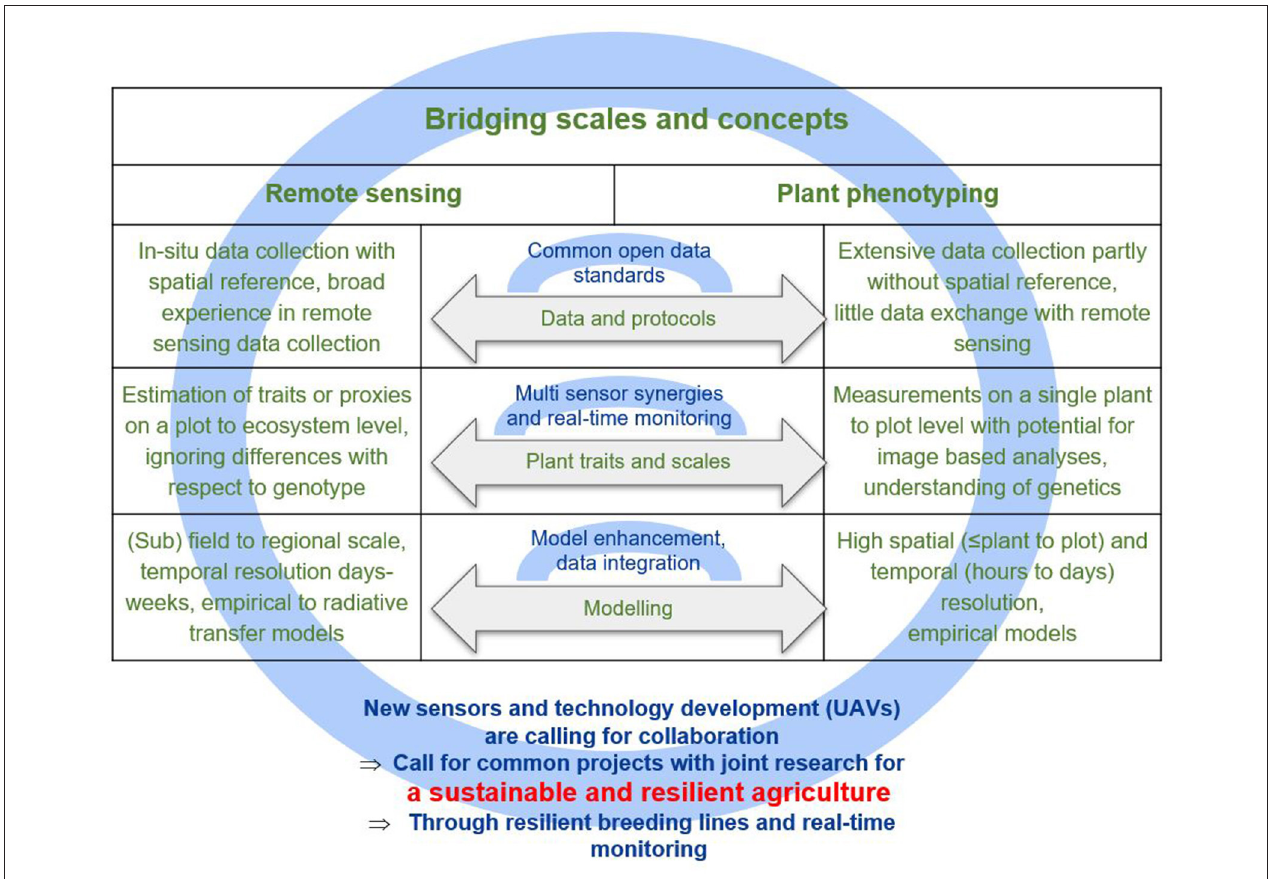
FIGURE 1 | A closer collaboration of remote sensing and plant phenotyping has the potential to foster research for a sustainable and resilient agriculture. Common topics between the two communities (gray arrows) have been identified for collaboration and cutting-edge research. In the left and right columns, differences between remote sensing and plant phenotyping are listed regarding the three topics. In blue, the potential for future collaboration is